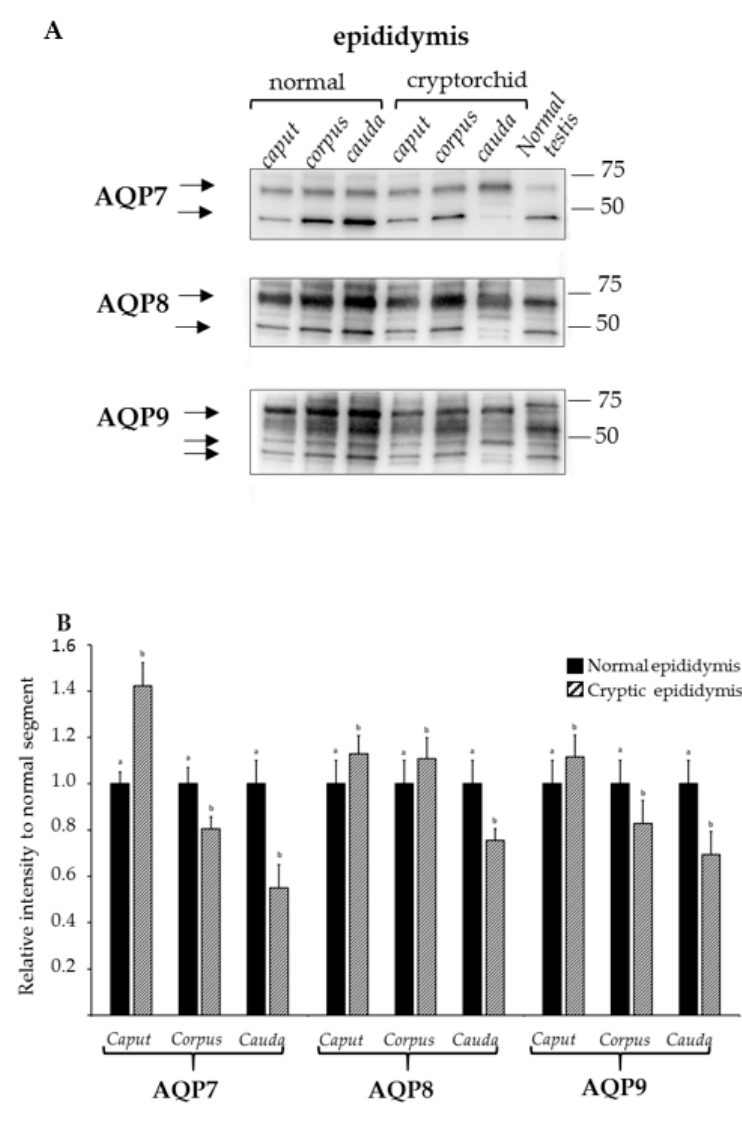
Figure 4. Western blotting of AQP7, AQP8, and AQP9 protein expression in the epididymis re- gions (caput, corpus, cauda) of normal and cryptorchid dogs. ( A ) Representative immunoblot; ( B ) densitometric analysis of AQP7, AQP8, and AQP9 protein expression. Results presented are the mean ± standard deviation of three independent experiments. Different letters depict differences between the examined groups ( p < 0.05).